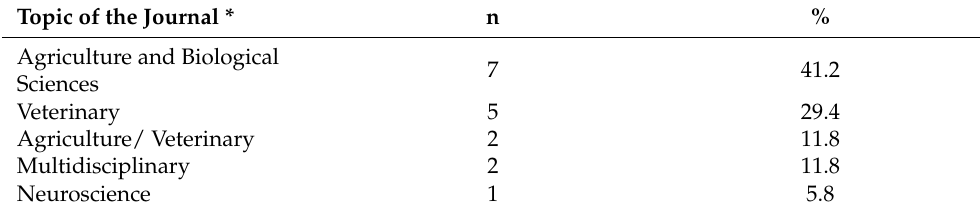
Table 4. Number and percentage of publications by topic of research of the peer-reviewed